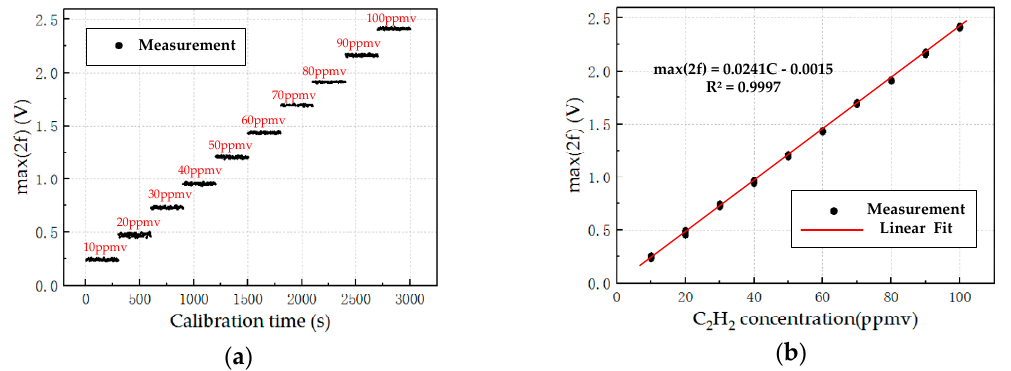
Figure 6. ( a ) Relationship between 2f signal’s amplitude (SA) and concentration C 2 H 2 (60 samples per group), and detection data recorded every 5 s. ( b ) Fitted curve of the 2f SA and concentration C 2 H 2 .